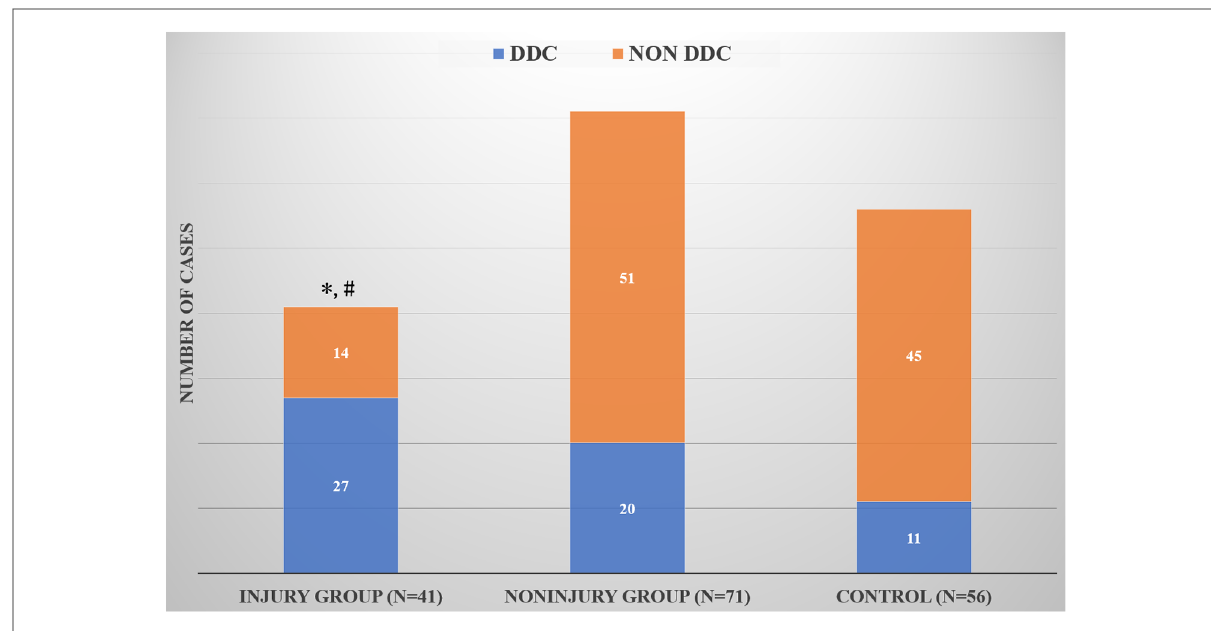
FIGURE 3 Comparison of DDC cases among the whole injury group, whole noninjury group and control group. *Compared with the control group, there was a signi fi cant difference; #Compared with the whole noninjury group, there was a signi fi cant difference.